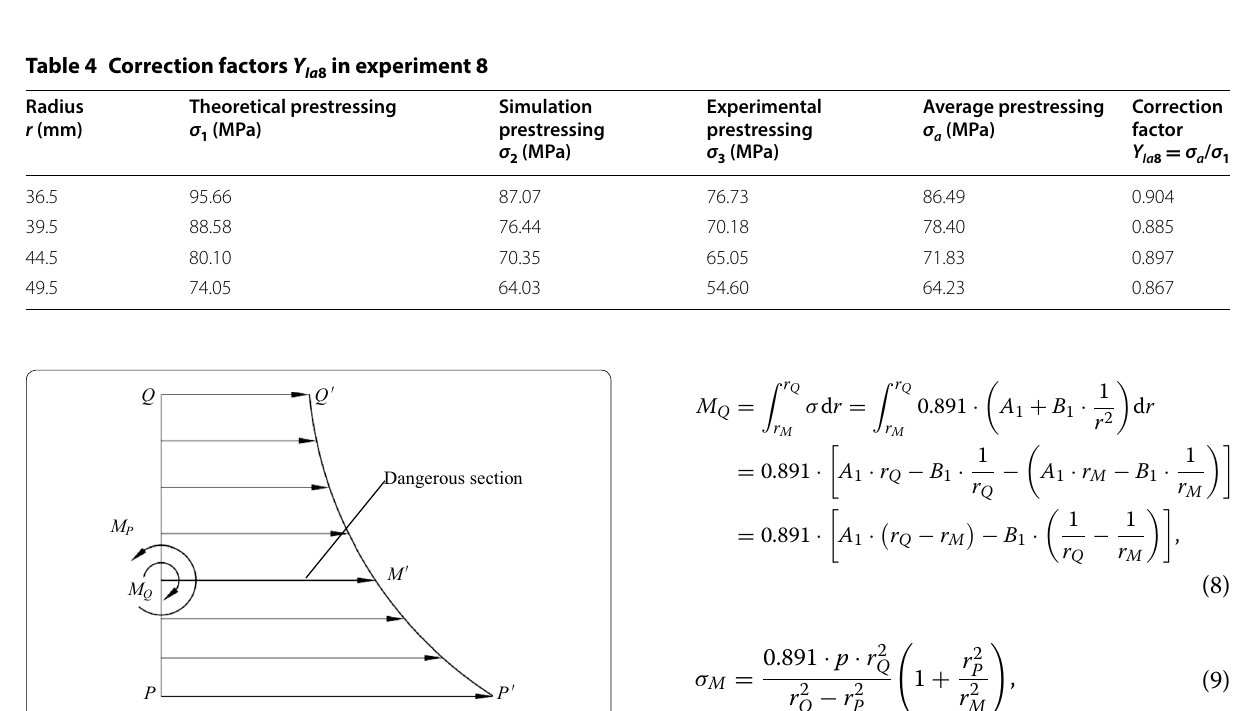
Figure 8 Force of the dangerous